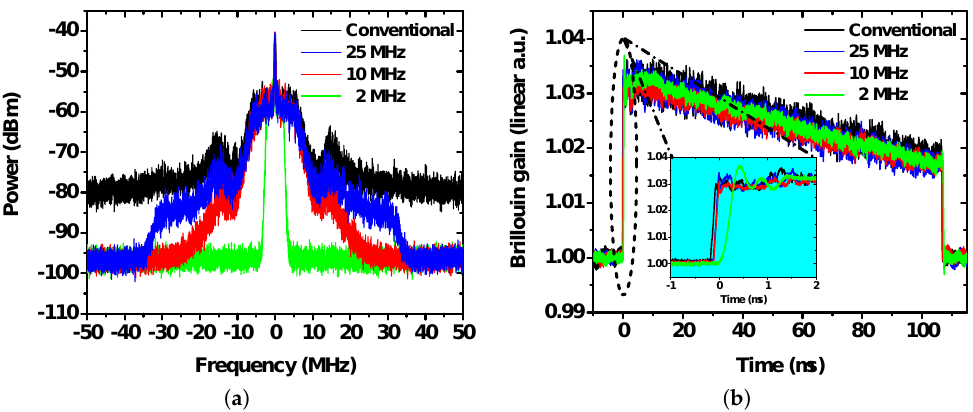
Figure 4. Experimental measurement results using RF low pass filtering: ( a ) RF spectrum measured by ESA; ( b ) time domain traces measured by a digitizer. The inset is the zoom in of the trace at the near end of the fiber.